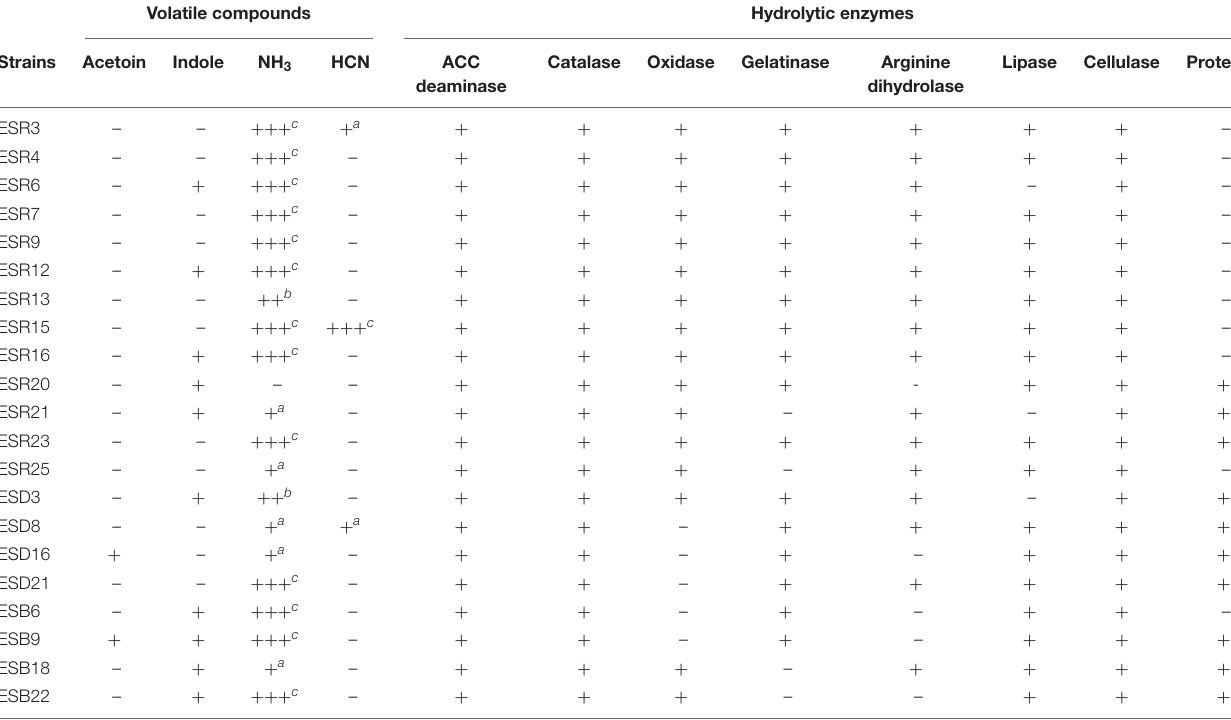
TABLE 3 | Production of volatile compounds and hydrolytic enzymes by different biofilm-producing rhizobacterial strains. Volatile compounds Hydrolytic